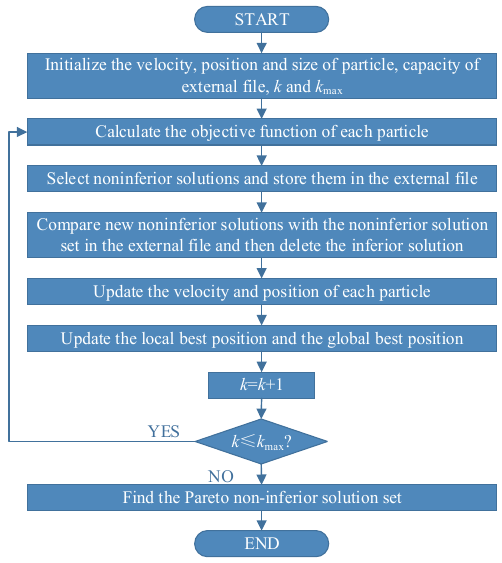
Figure 3. Flowchart of MOPSO.